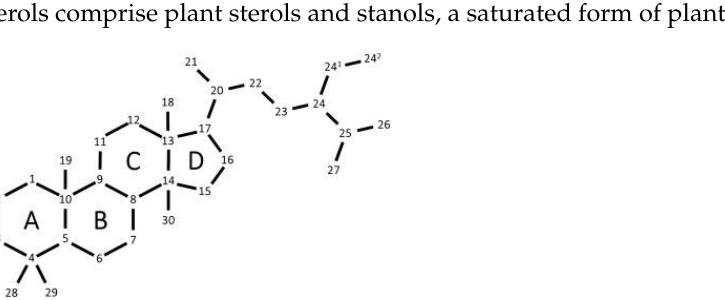
Figure 5. Schematic structure of the steroid skeleton.